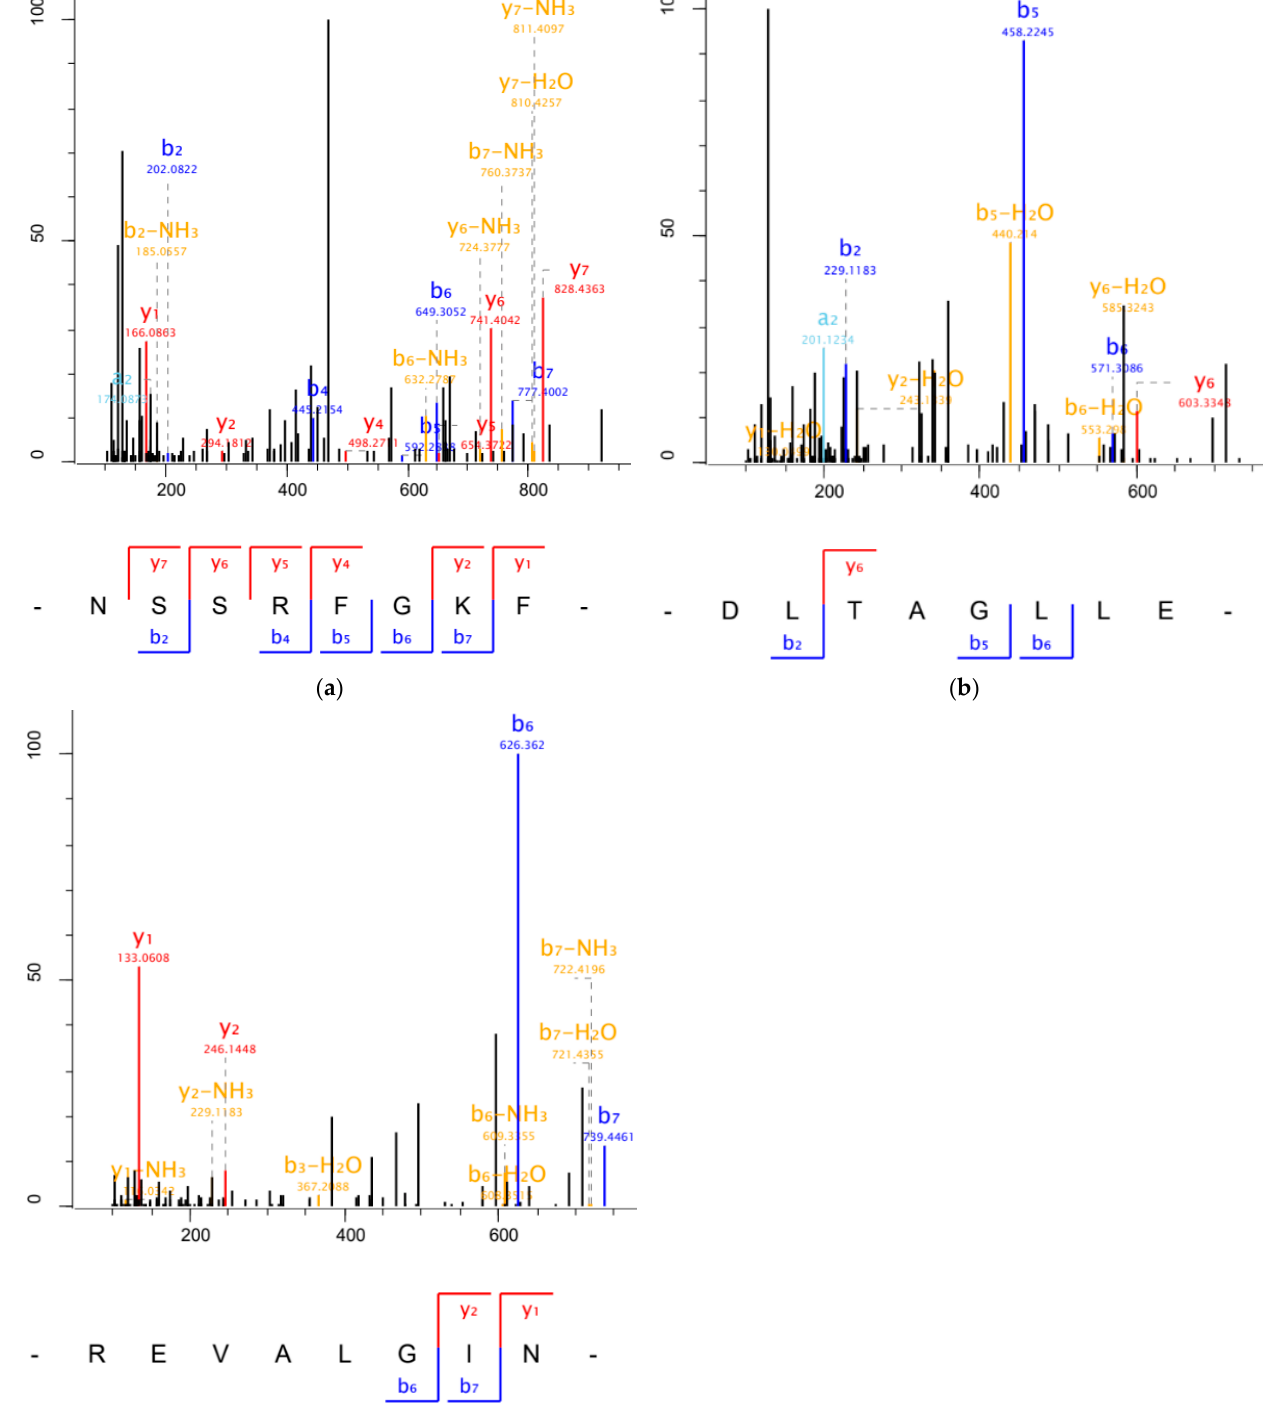
Figure 4. Molecular masses and amino acid sequences of ACE-inhibitory peptides from the purified F4-12 fraction. MS/MS spectra of NSSRFGKF ( a ), DLTAGLLE ( b ), and REVALGIN ( c ).